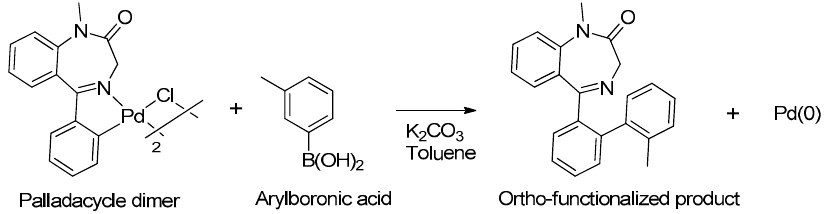
Figure 10. Ortho -functionalization of cyclopalladated 5-phenyl-1,4-benzodiazepine.